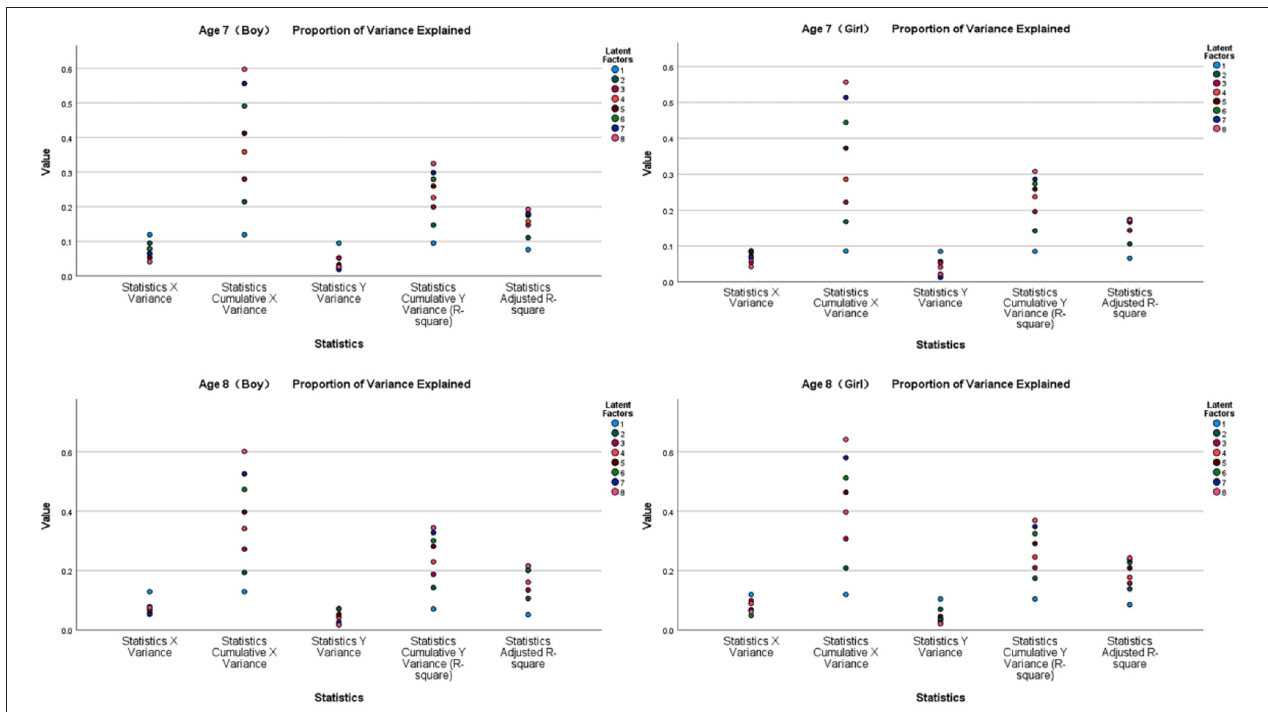
FIGURE 6 | Explanation and analysis of motor development on motor performance.